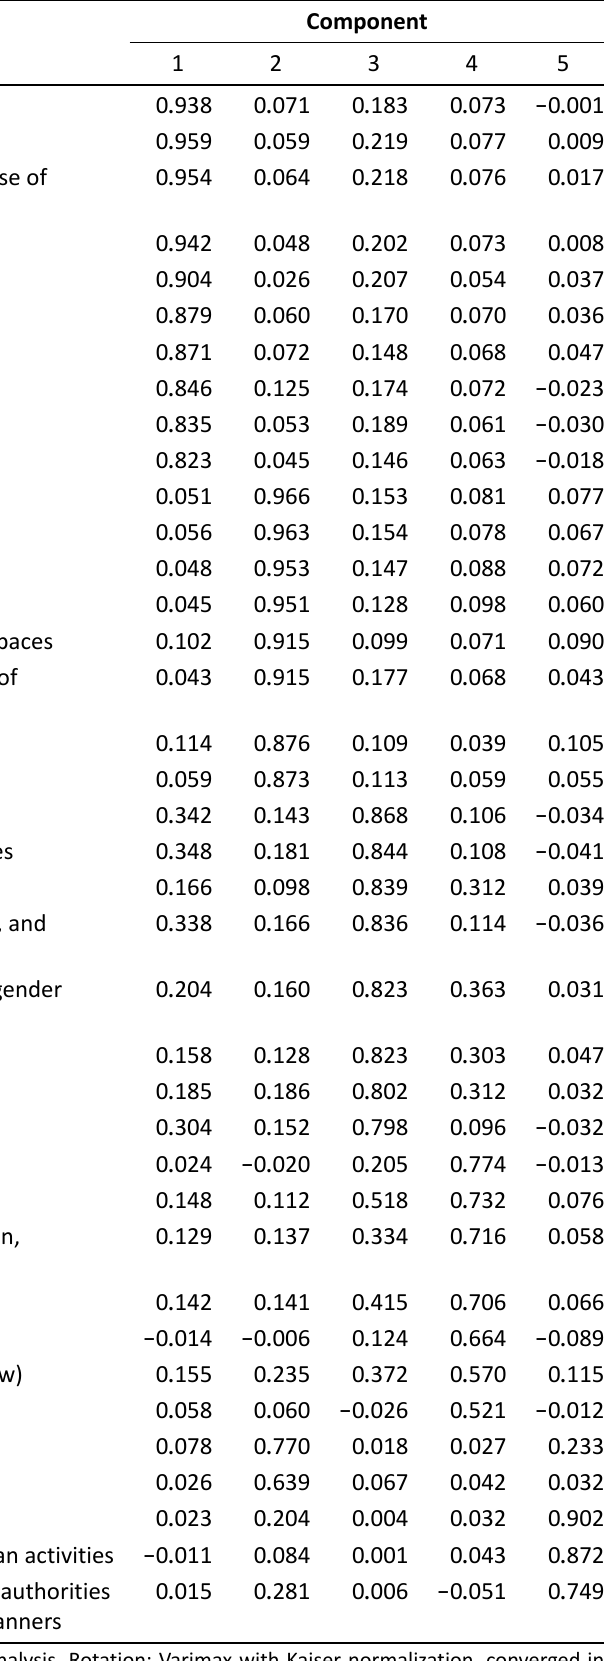
Table 6. Rotated component matrix showing the factor loadings for each factor under different components.